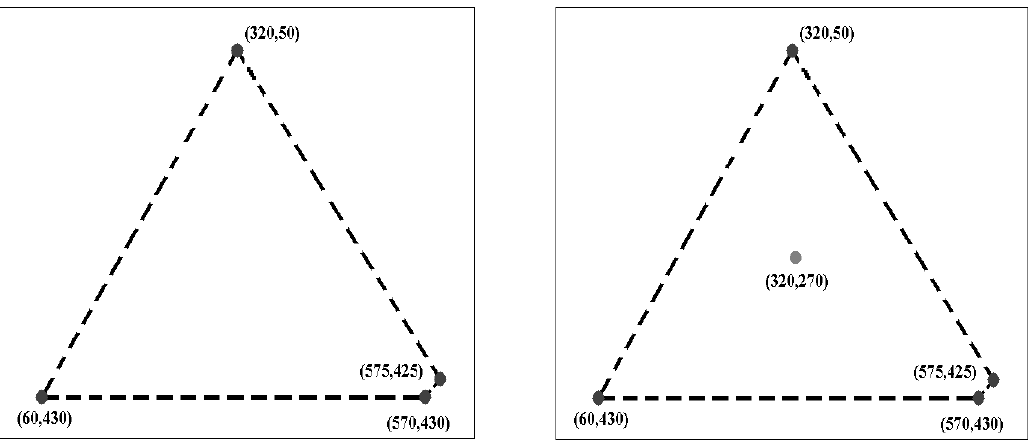
Figure 1. A simple example: ( left ) an image with four detected interest points and their convex hull; ( right ) the same image with an additional detected interest point and convex